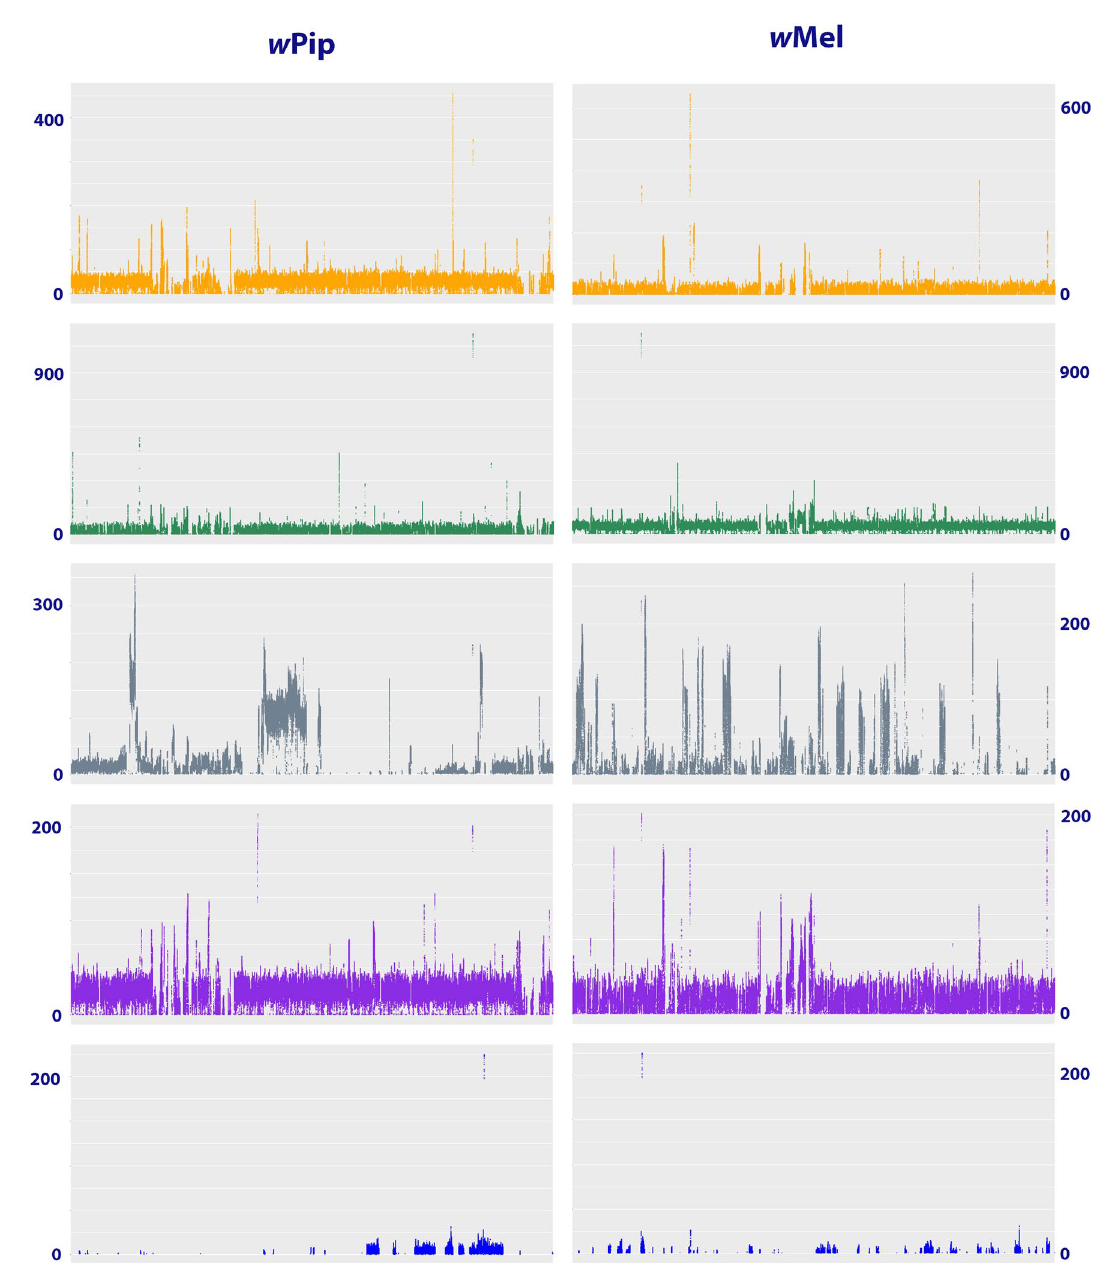
Figure 1. The mapped reads to w Mel and w Pip Wolbachia reference genomes. The coverage is shown on the vertical side of the figure. The top graphs (yellow) correspond to the sample RZ337 ( Oraesia excavata ), followed by RZ271 ( Idia aemula in green), RZ248 ( Acantholipes circumdata in grey), RZ42 ( Luceria striata in purple) and at the bottom RZ13 ( Gonitis involuta in